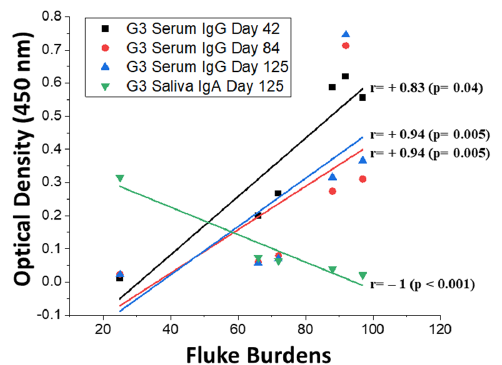
Figure 7. Spearman correlations between bovine humoral responses and the final liver fluke bur ‐ in Group 3. Significant positive relationships were noted between fluke burdens and serum IgG at Day 42 (black: r = +0.83, p = 0.04), Day 84 (red: r = +0.94, p = 0.005), and Day 125 (blue: r = +0.94, p = 0.005), for Group 3 (G3) subcutaneously vaccinated with rFhTSP2. A significant negative relationship was seen for G3 between fluke burdens and saliva IgA at Day 125 (green: r = − 1, p < 0.001). No significant correlations were seen between fluke burdens and serum or saliva responses for Group 2 after rLTB- FhTSP2 vaccination (Table S1). Linear regression lines display the significant relationships between antibody enzyme-linked immunosorbent assay optical density and the individual fluke